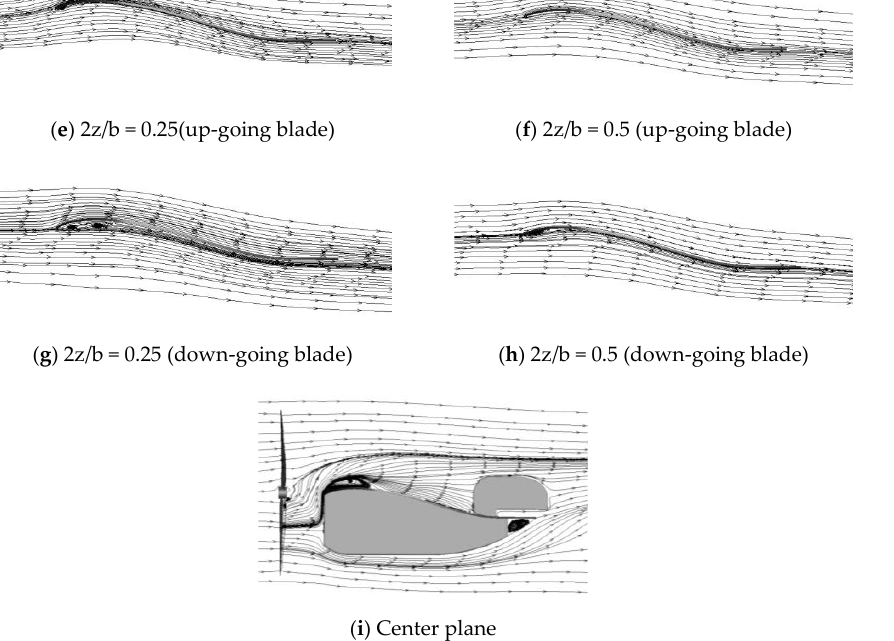
Figure 10. Instantaneous flow structure around the MAV at α = 0 ◦ , ϕ = 0 ◦ , ( a – d ) flow field around MAV, ( e , f ) airfoil sectional flow structure with up-going blade at spanwise location of 2z/b = 0.25 and 0.5, ( g , h ) airfoil sectional flow structure with down-going blade at spanwise location of 2z/b = 0.25 and 0.5, ( i ) flow structure at propeller’s azimuth angle ϕ = 0 ◦